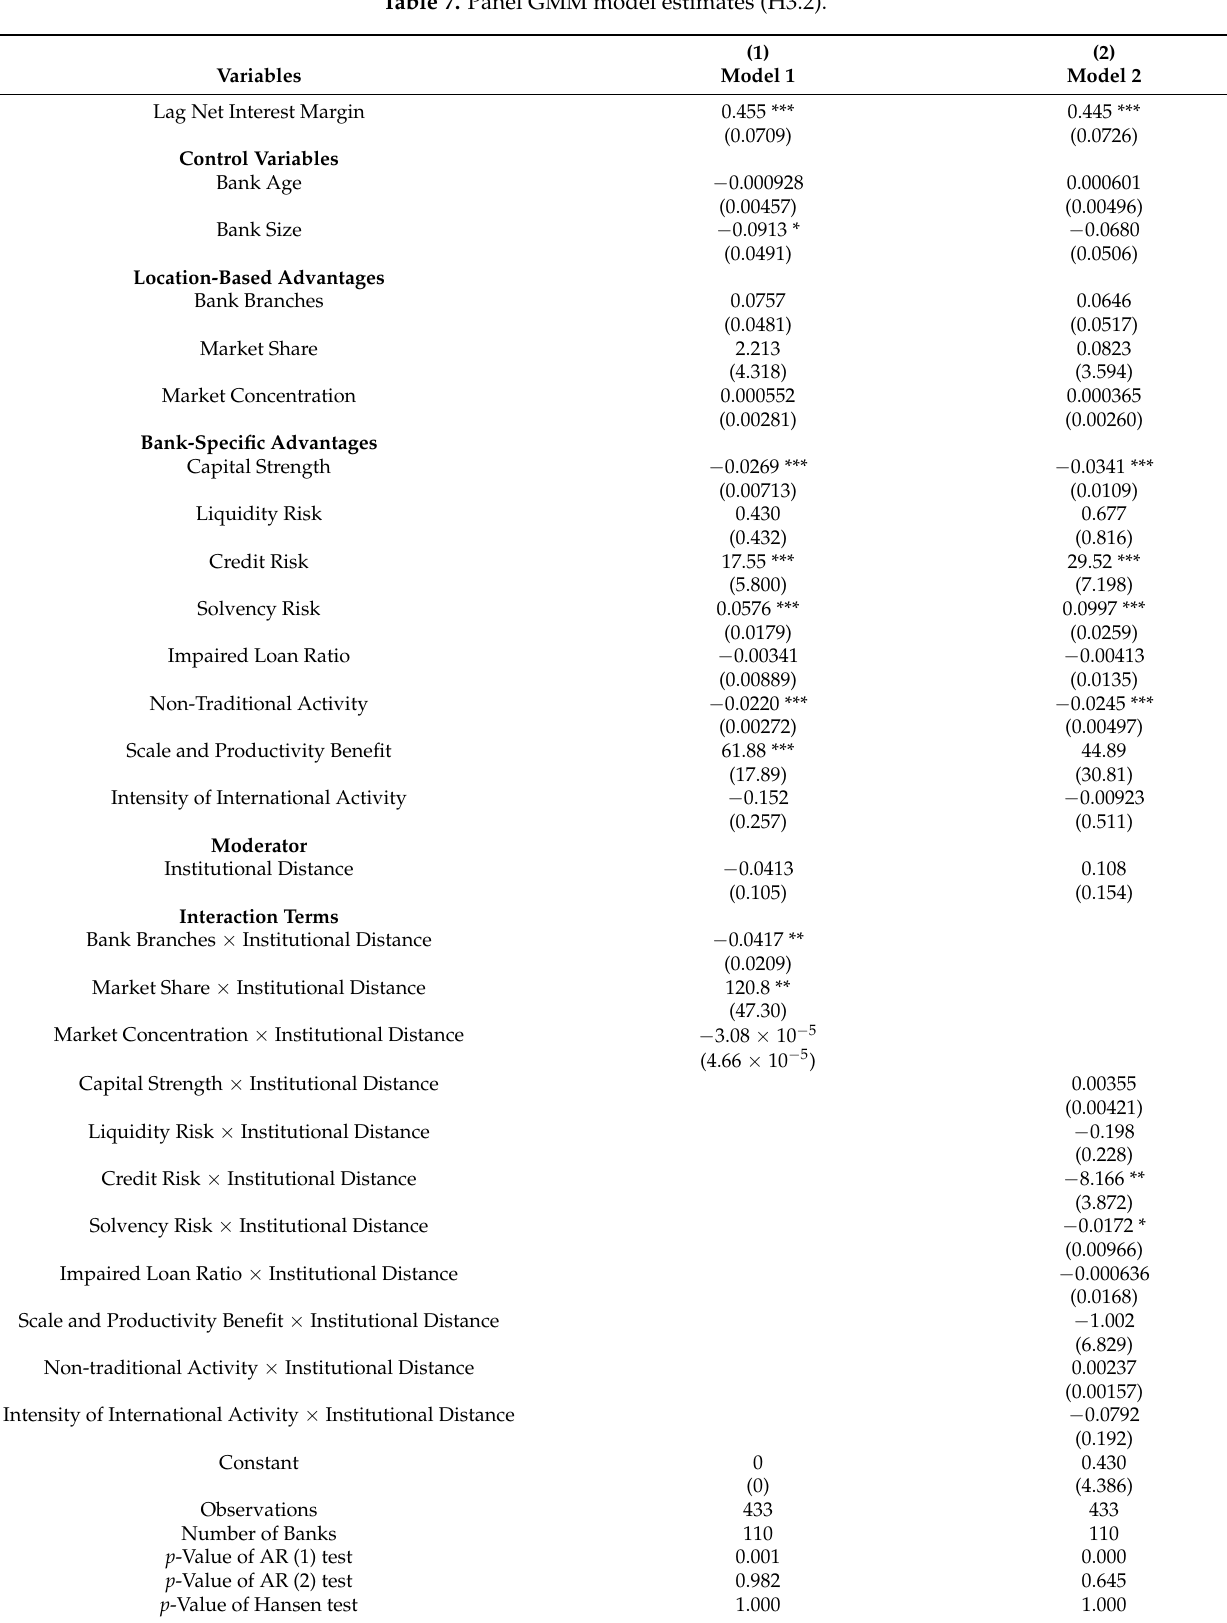
Table 7. Panel GMM model estimates